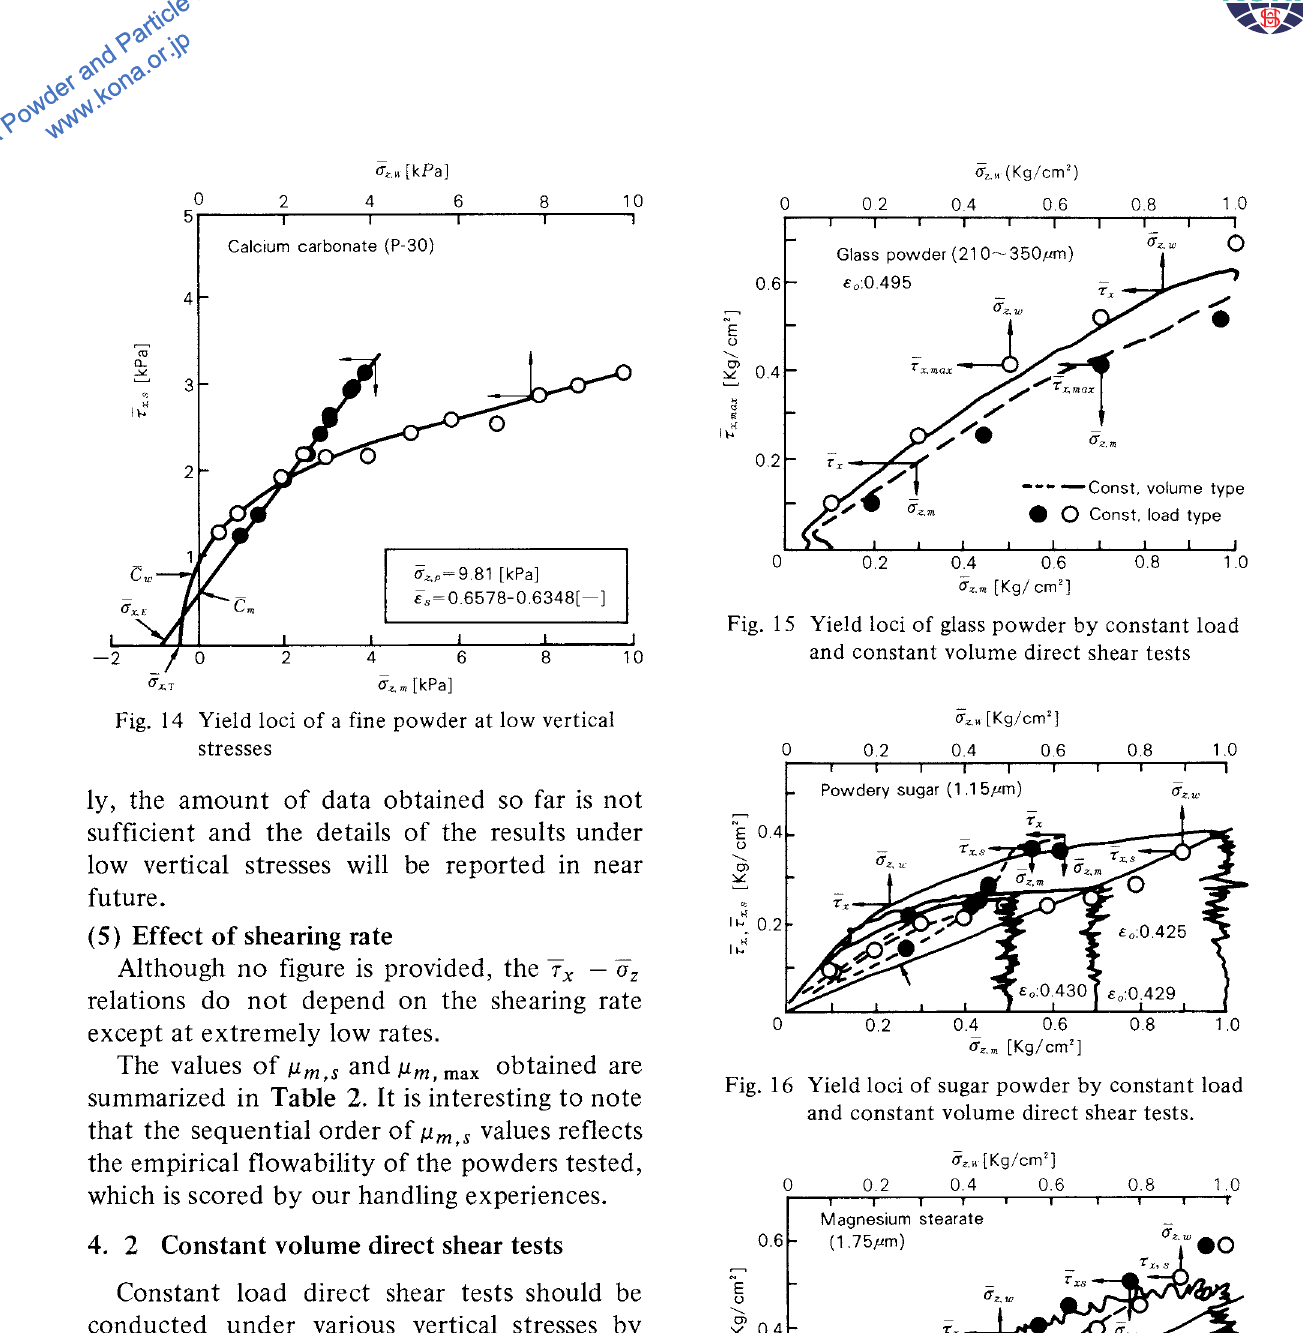
Fig. I 7 Yield loci of magnesium stearate by constant load and constant volume direct shear